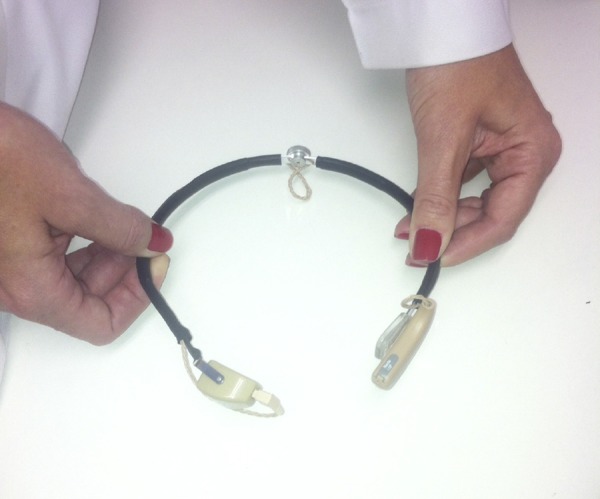
Modelo de prótese.